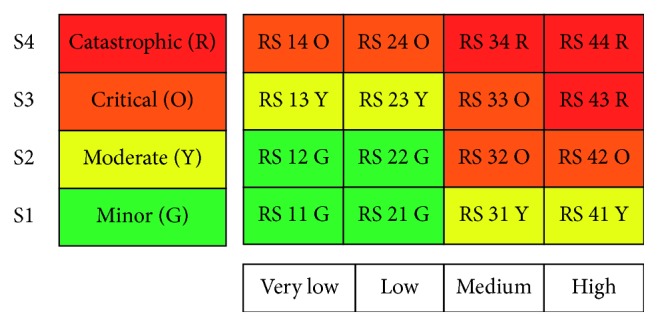
The risk matrix form.